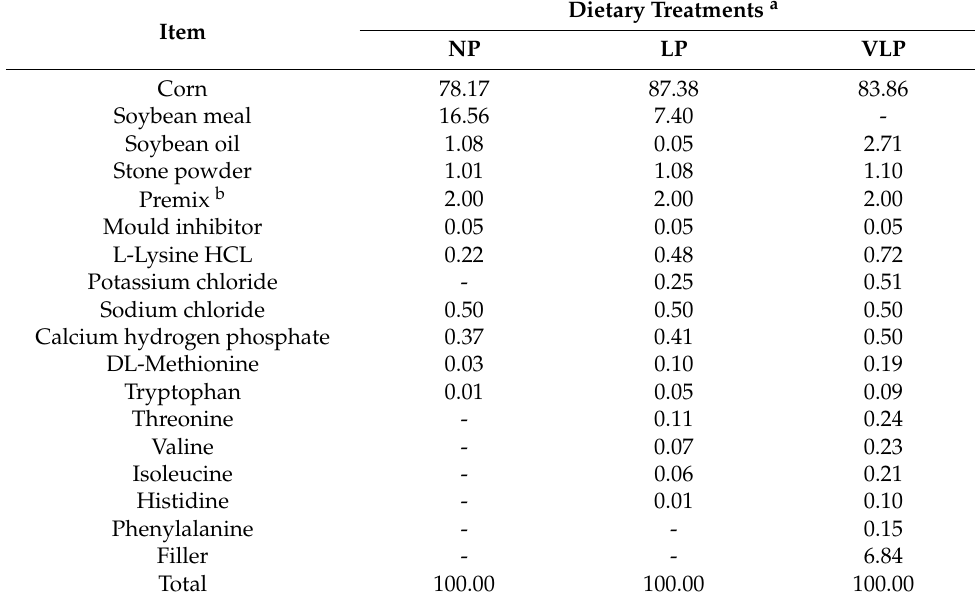
Table 1. Ingredient Composition and Nutrient Levels of the Experimental Diets. (%, as-fed